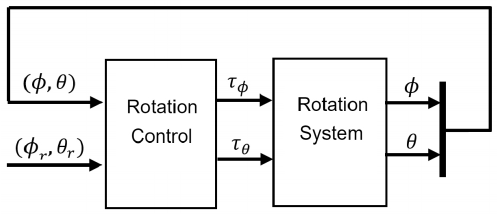
Figure 11. Control scheme for rotation system.